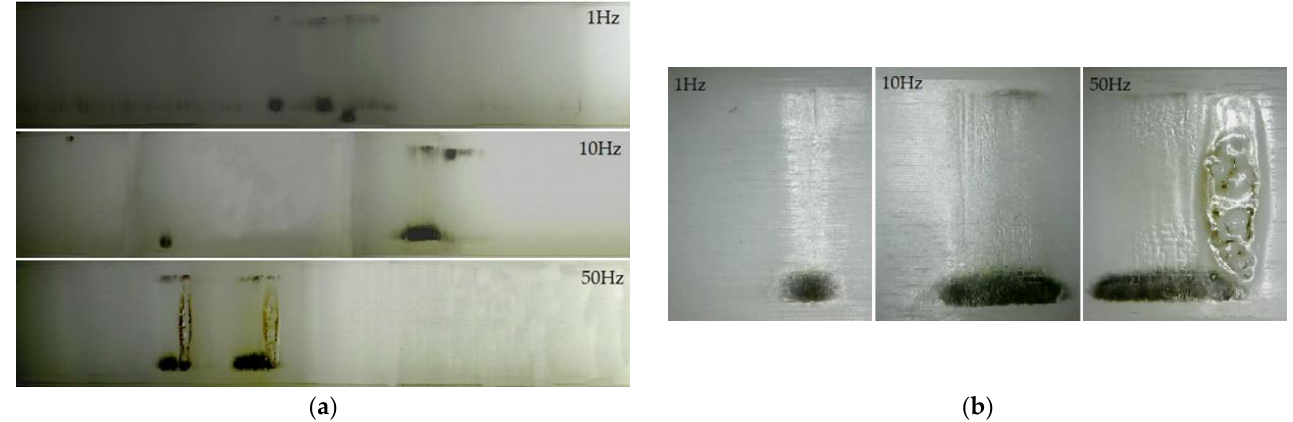
Figure 10. Image of discharge traces including ( a ) the whole surface and ( b ) flashover channels area after 5000 flashovers under different PRFs.